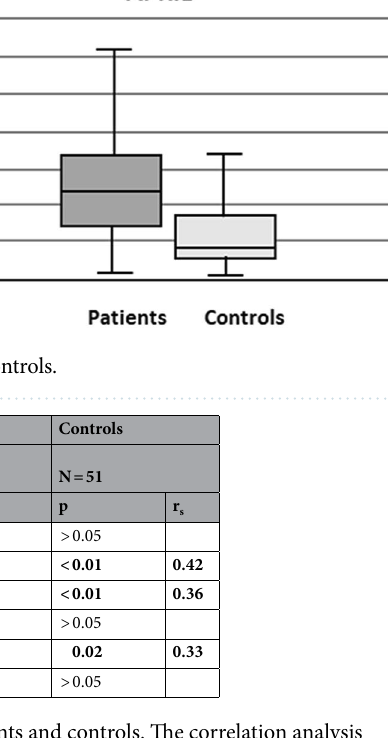
Table 2. Correlation between different pairs of markers in patients and controls. The correlation analysis was performed only with those individuals with available data in all the assays. Only the r s values of those statistically significant correlations (p-values < 0.05) are displayed (shown in